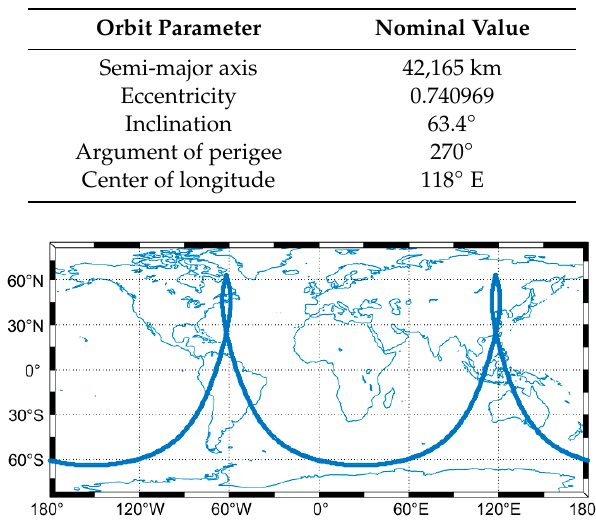
Table 5. Highly eccentric orbits (HEO) parameters.